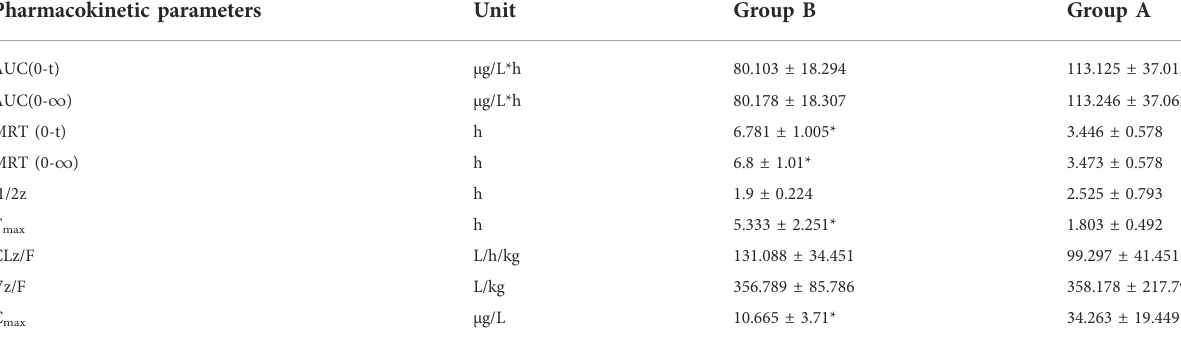
TABLE 2 Pharmacokinetic parameters of desmethyl fl uvoxamine. Pharmacokinetic parameters